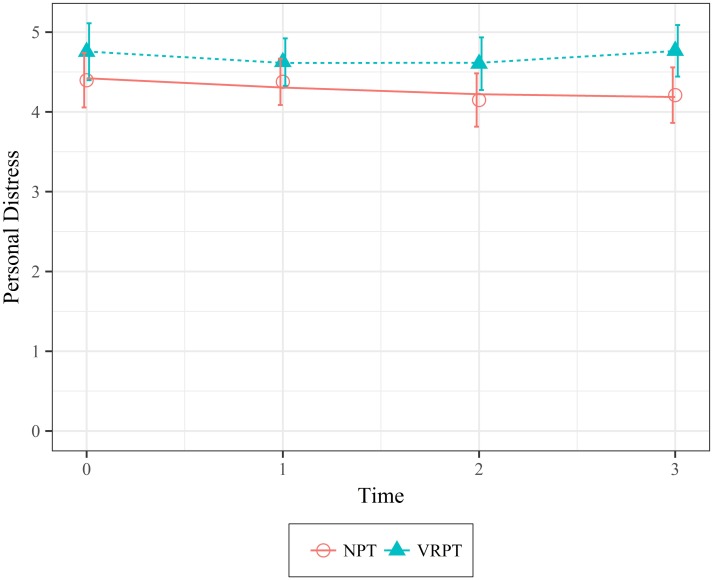
Mean values of personal distress as a function of condition over time.Error bars represent 95% Confidence Intervals.